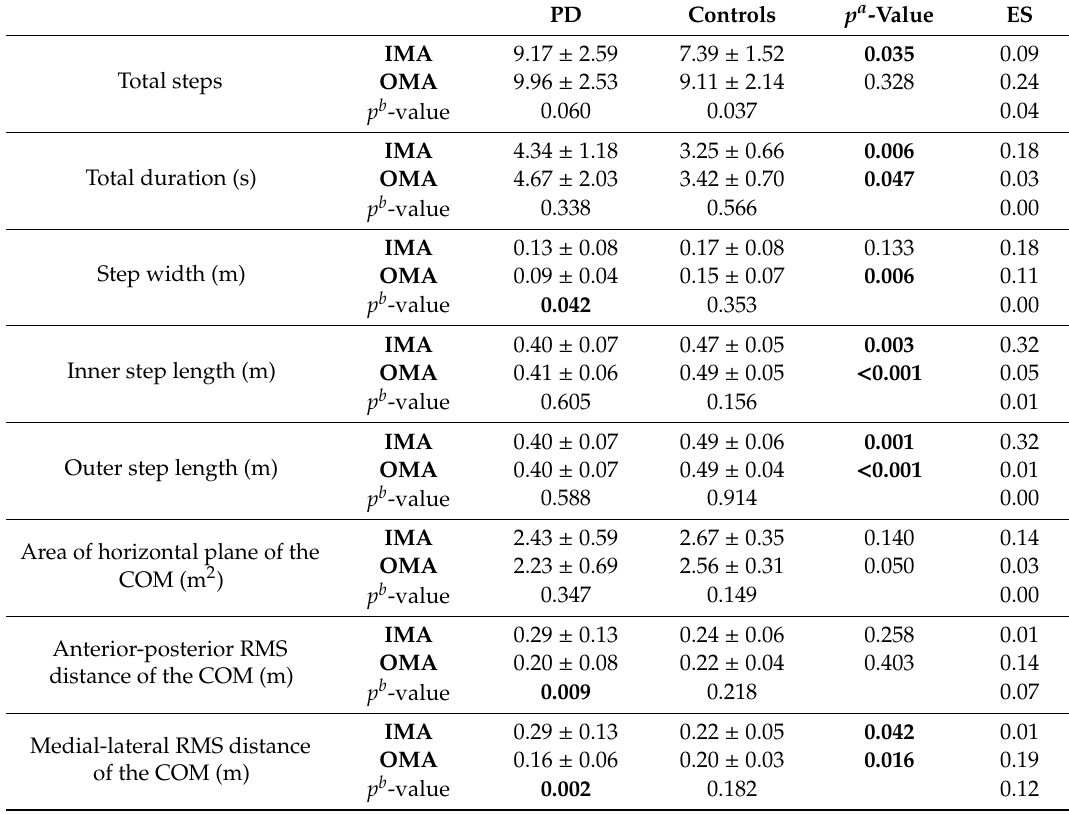
Table 2. Comparison of turning characteristics of PD patients and controls for the 360 ◦ turning task at maximum